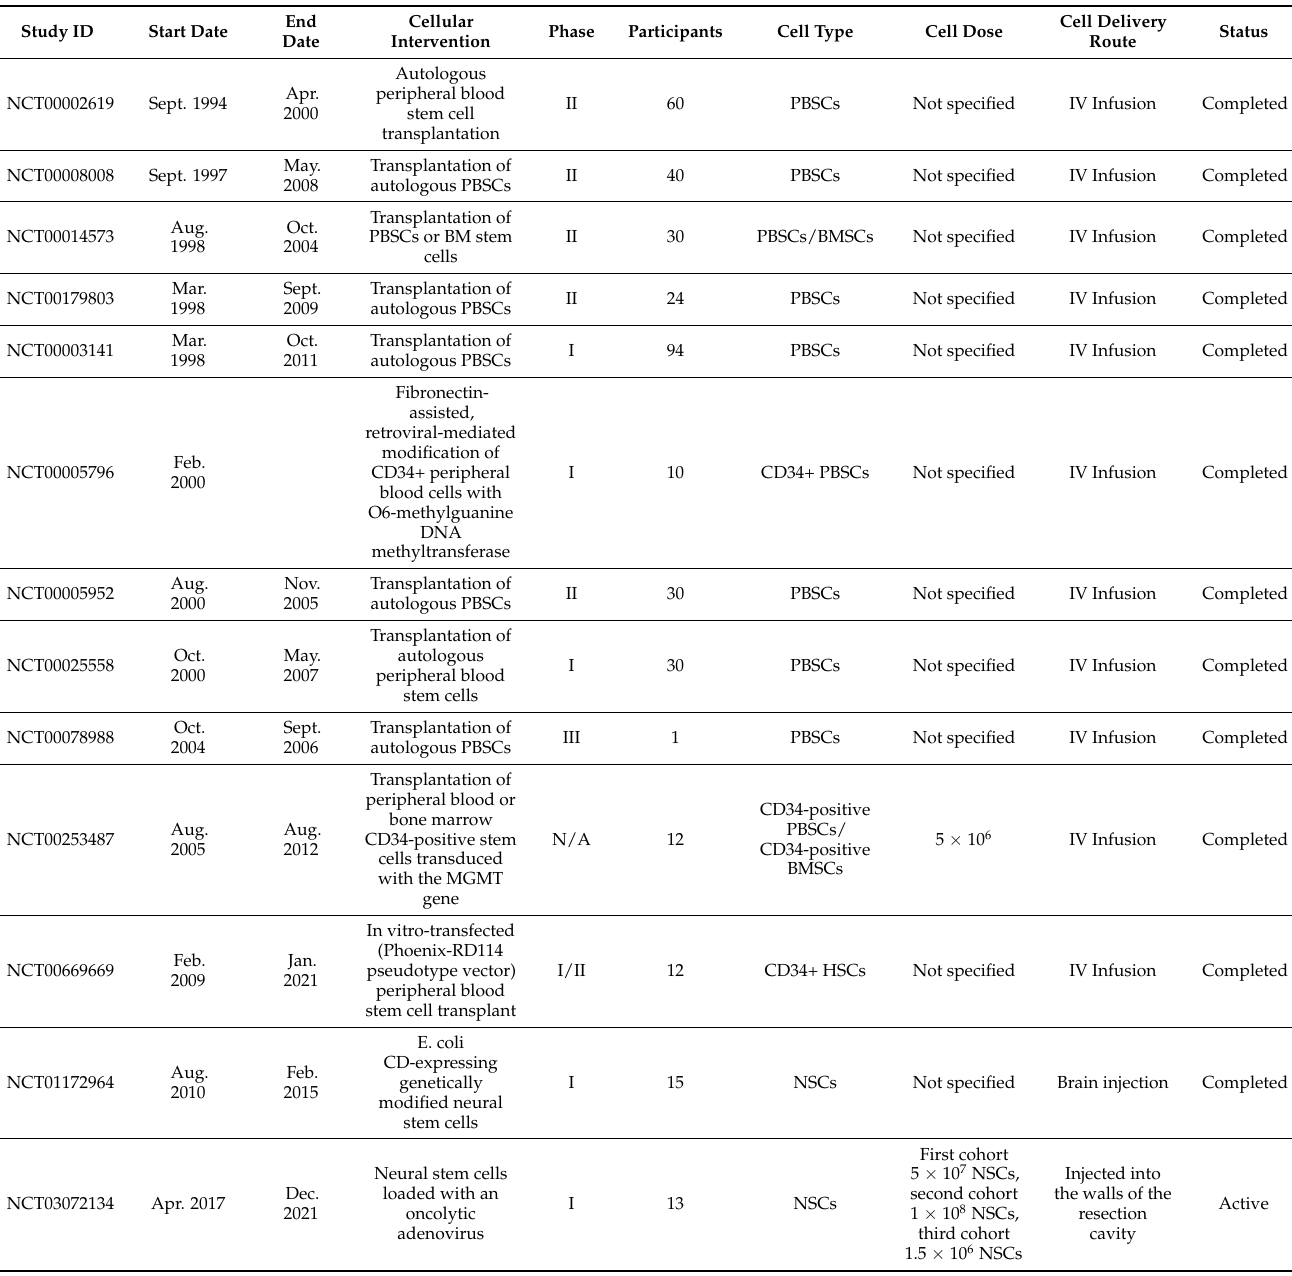
Table 2. Clinical trials on stem cell therapy for